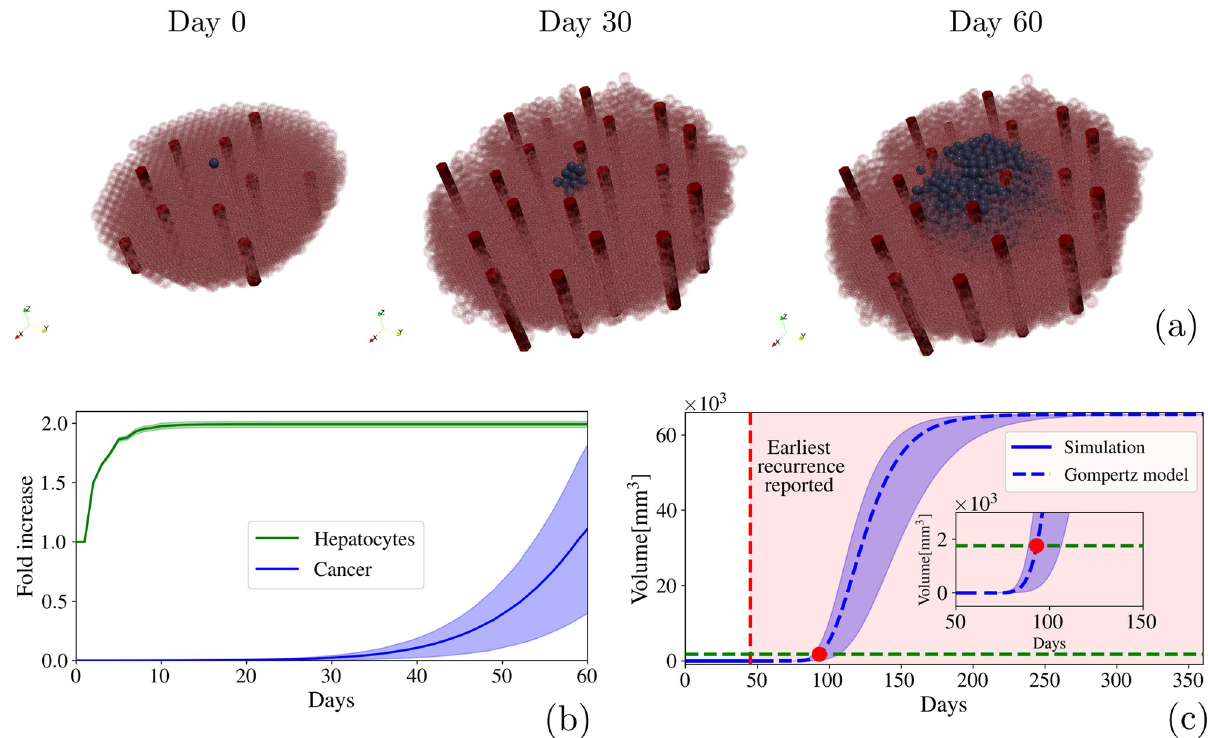
Fig 10. Hepatocellular carcinoma. (a) Schematic representation of the recurrence of a hepatocellular carcinoma after a 70% PH. Hepatocytes are represented by transparent pink cells to have a better view of the blood vessels (red tubes) and the tumor (blue cells) growth (b) Fold-increase in liver regeneration and hepatocellular carcinoma recurrence. (c) Time based volume estimation of the hepatocellular carcinoma by using simulation data (blue line) to adjust a Gompertz model growth curve (blue dotted line). Red dotted line represents the earliest recurrence reported in clinical observations and the red point along with the green dotted line,represents the minimum volume that the tumor must reach to be detected (5 mm) by imaging diagnose.